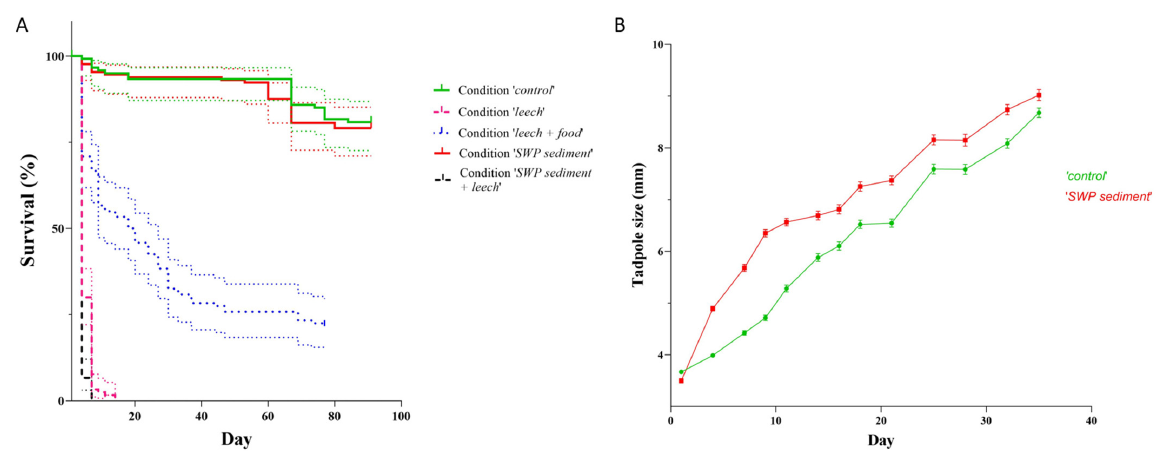
Figure 3. ( A ) The Kaplan–Meier survival curve found a lower survival rate for tadpoles exposed to conditions 2 (“leech”) and 4 (“SWP sediment + leech”; pink and black dashed lines) than for condi- tions 1 (“control”) and 3 (“SWP sediment”; solid green and red line; χ ² = 528.1, d = 3, p < 0.001) Tadpole survival for condition 2b (“leech + food”, blue do tt ed line), was lower than in conditions 1 and 3 ( χ ² = 106.9, d = 1, p < 0.001) but greater than in conditions 2 and 4. ( B ) Growth curve of Euro-